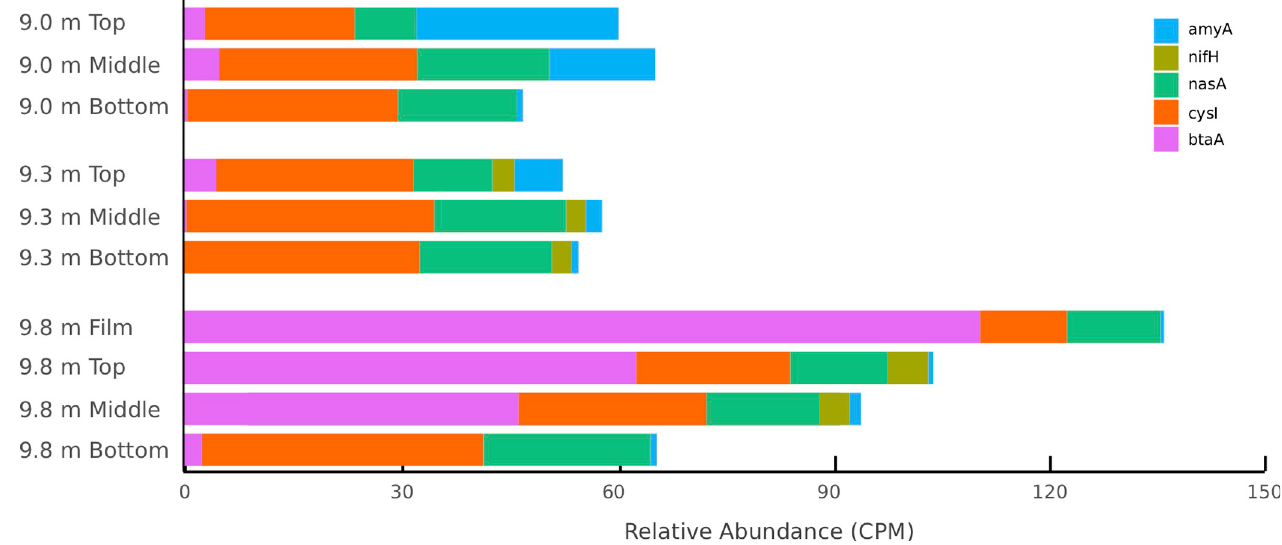
Fig 7. Nutrient assimilation capacity. Predicted capacity differs among lake depth and mat layer, as estimated from metagenomic sequence data. Nitrogen fixation genes ( nifH ) are absent from habitats supersaturated with oxygen as well as the film at 9.8 m, which is seasonally oxic.